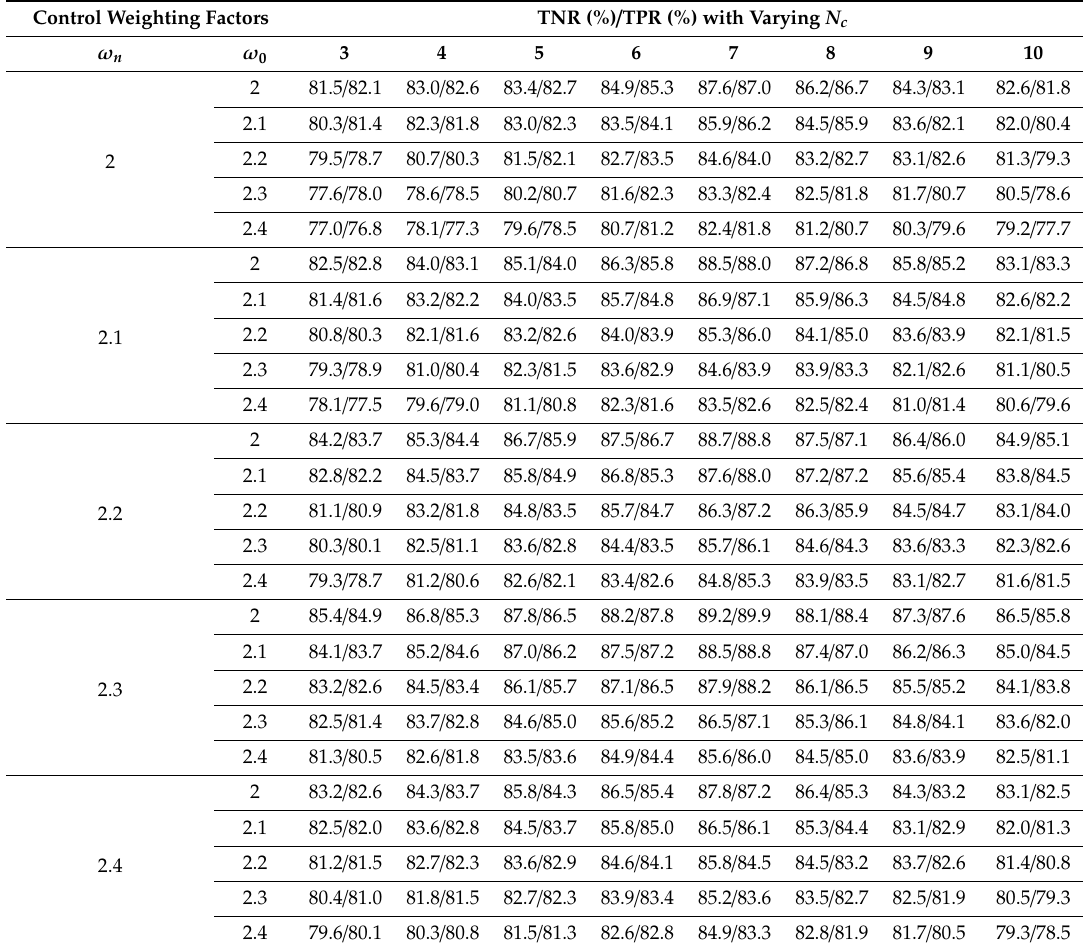
Table 5. Performance evaluation of the multi-class detection model using CGAN-IFCM under varying N c , ω n , and ω 0 values with the VOICED database. (a) Fixed ω n = 1.8. (b) Fixed ω n = 1.9. (c)